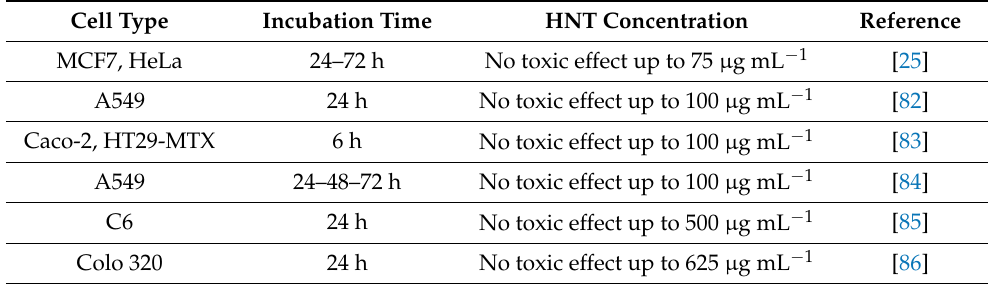
Table 1. Cytotoxicity of HNTs towards different cell